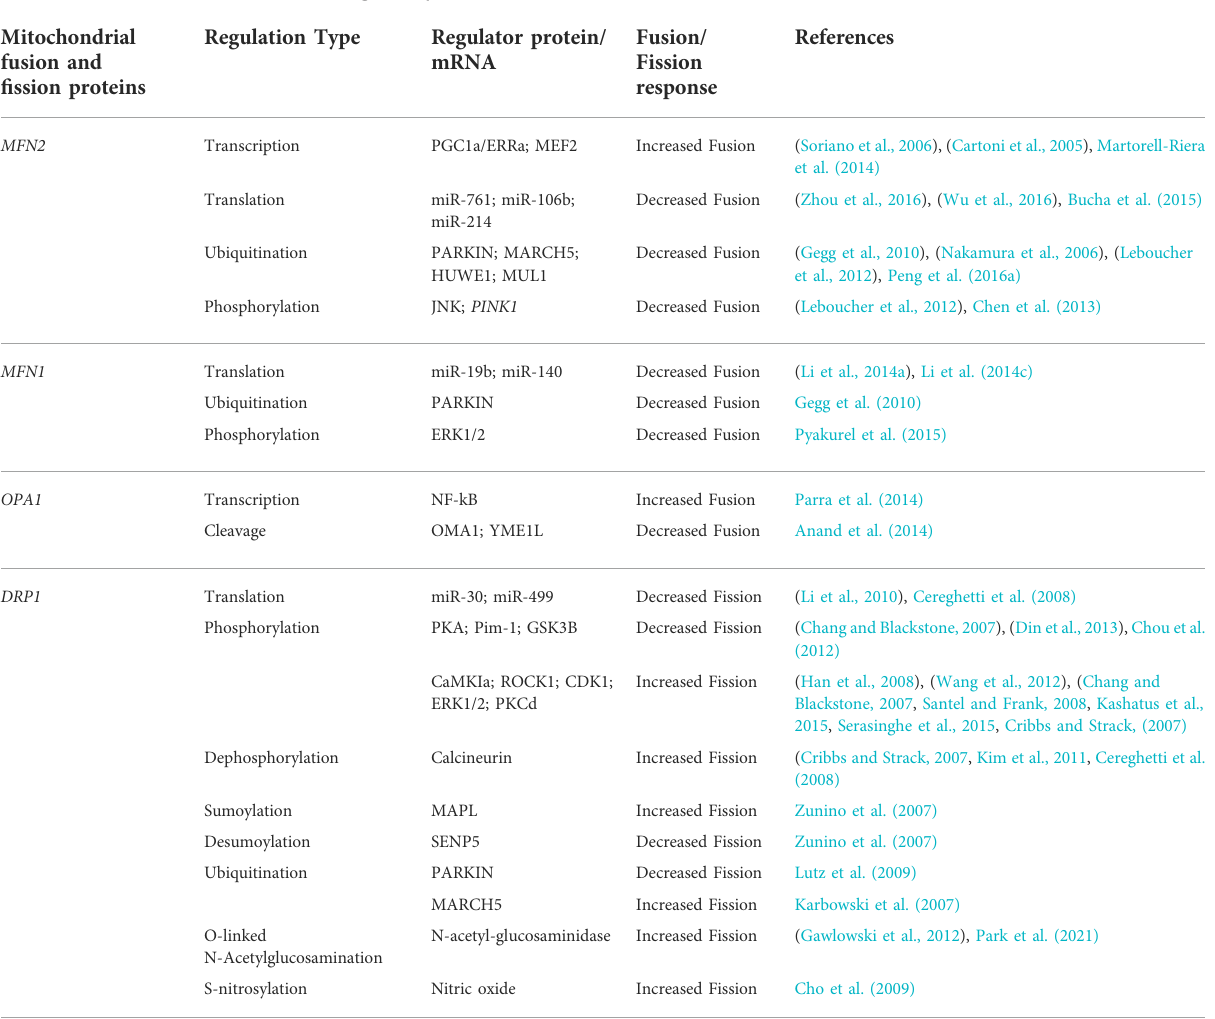
TABLE 1 Mitochondrial fusion and fi ssion regulator